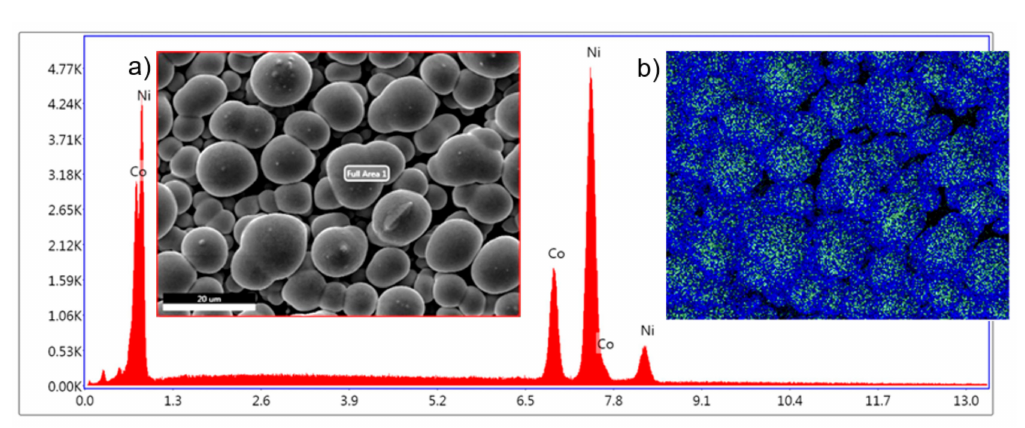
Figure 8. Illustration showing the growth of nanowire “mushroom” caps after the nanowires reached the surface. The membrane surface is illustrated here as a transparent area to better see the nanowires embedded in the membrane. SEM image of analyzed area ( a ) and EDAX color map showing the presence of both Co and Ni in the structures ( b )